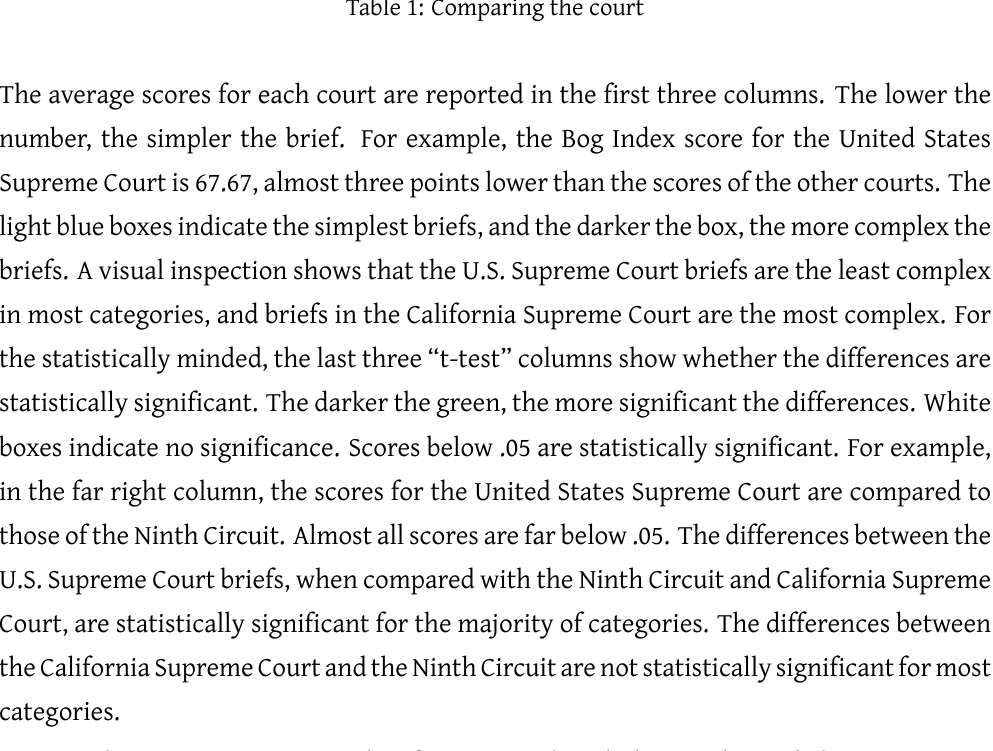
Table 1: Comparing the